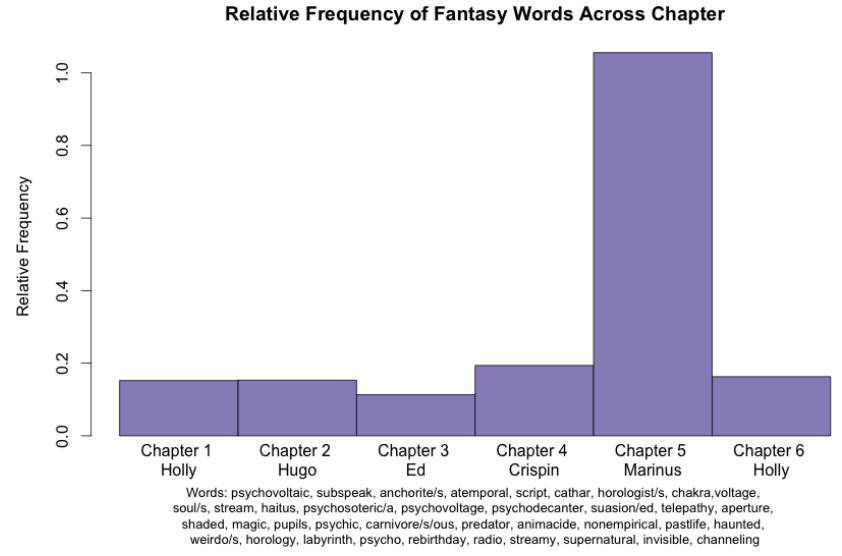
Figure 4. The relative frequency of words associated with the fantasy subplot. The fantasy slowly builds in each of the chapters until the penultimate one then drops off again suddenly in the final chapter when climate makes its comeback.